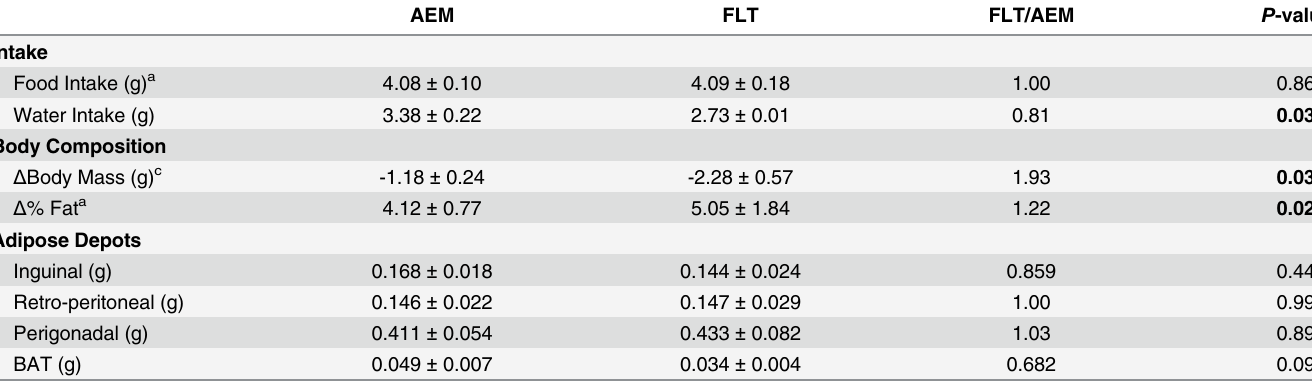
Table 1. Food intake and body composition measurements for AEM controls and FLT